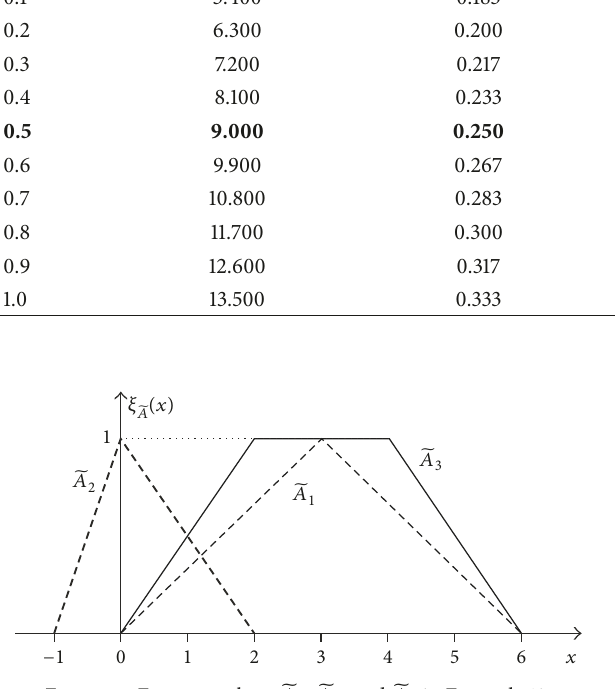
Figure 7: Fuzzy numbers index should discriminate